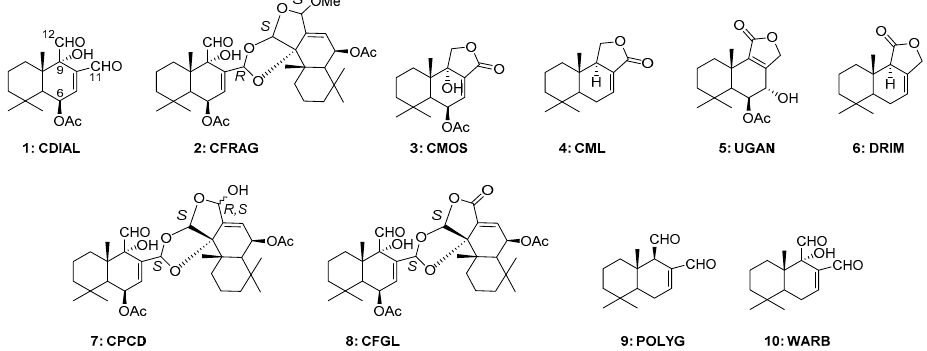
Figure 1. Structures of isolated compounds. Carbons referred to in the text are numbered in cinnamodial (CDIAL). CFRAG = cinnafragrin A; CMOS = cinnamosmolide; CML = cinnamolide; UGAN = ugandensolide; DRIM = drimenin; CPCD = capsicodendrin; CFGL = cinnafragrolide; POLYG = polygodial; WARB =